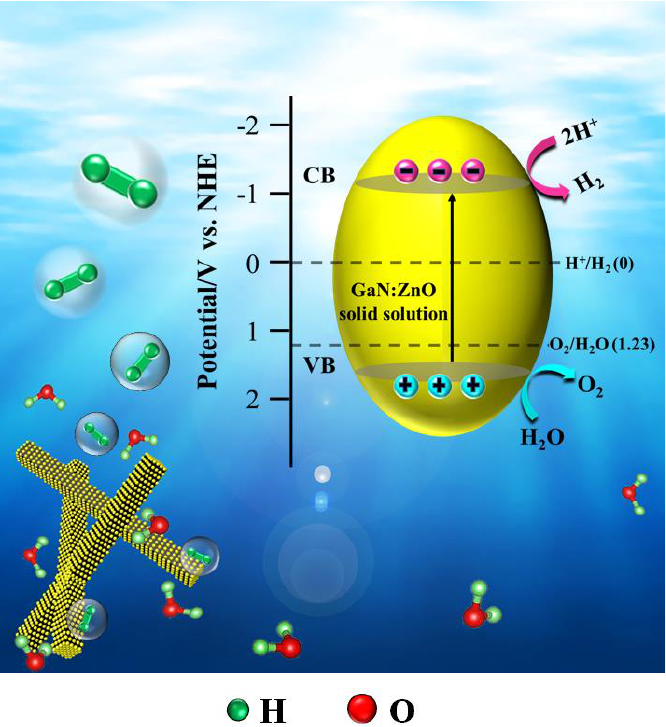
Figure 6. A schematic illustration of the electronic band structure and the photocatalytic H 2 genera- tion mechanism of GaN:ZnO solid